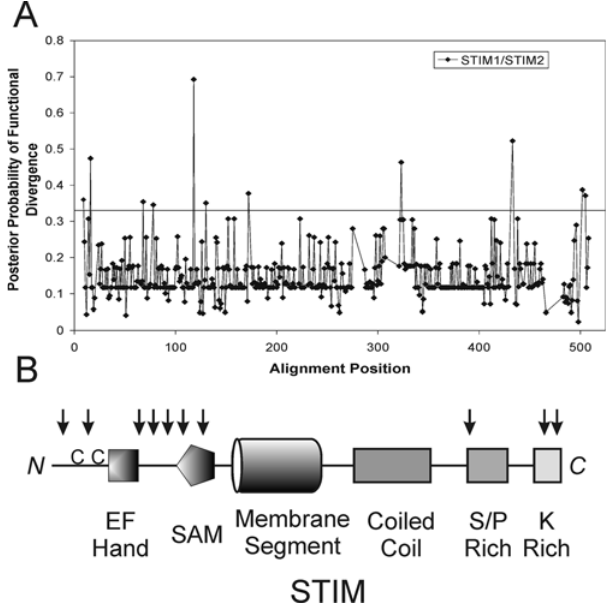
Figure 5. Sites with altered evolutionary rates identified by posterior probability of functional divergence. A. The posterior probability of functional divergence between vertebrate STIM-1 and STIM-2 branches were calculated with the program DIVERGE [31]. 11 of the aligned sites showed posterior probabilities . 0.33. The 9th site fell in a less defined region and was excluded for further analysis. The neighbor-joining tree used for DIVERGE (Fig. S1) is available in Supplementary Information. B. The localization of the residues with significant posterior probabilities was mapped onto the structural model of vertebrate STIM molecules, indicated with black arrows . The highly conserved double cysteine-pair region is shown as a double ‘‘C’’ before the EF-hand domain in the N- terminus. C , C terminus; N , N